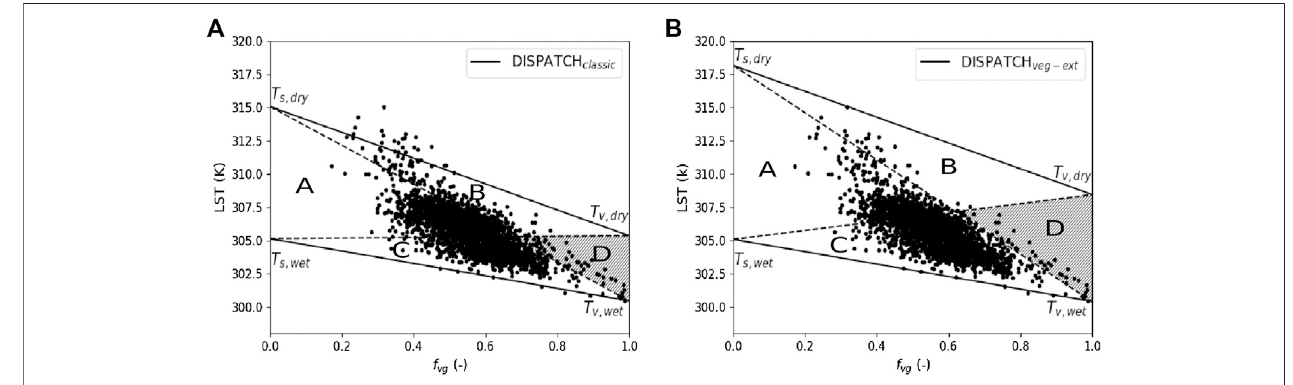
FIGURE 3 | Illustration of DISPATCH classic (A) and DISPATCH veg – ext (B) polygons in the LST- f vg feature space for ICOS study area on DOY 204,